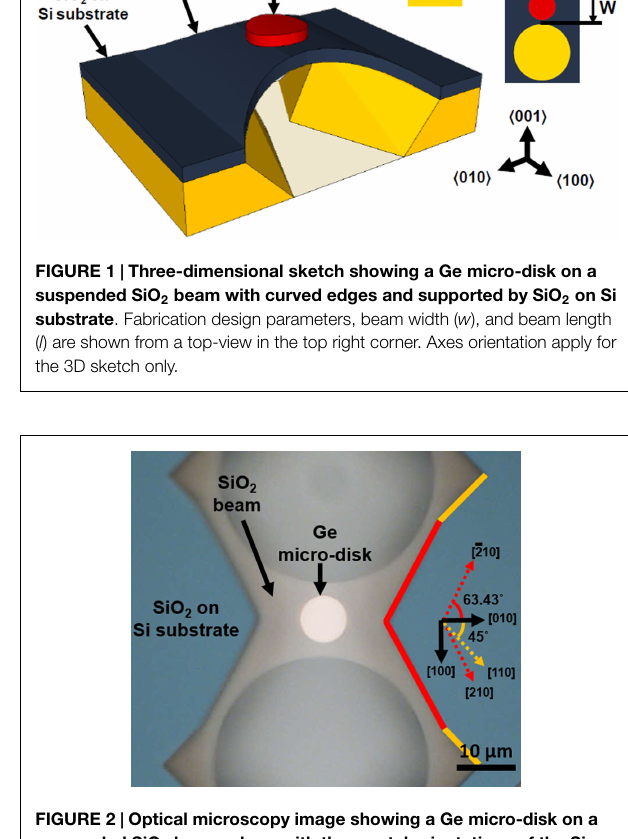
FIGURE 2 | Optical microscopy image showing a Ge micro-disk on a suspended SiO 2 beam, along with the crystal orientations of the Si substrate . Anisotropy of TMAH wet-etching of Si through circular hole openings is determined by ⟨ 110 ⟩ and ⟨ 210 ⟩ Si lattice orientations.